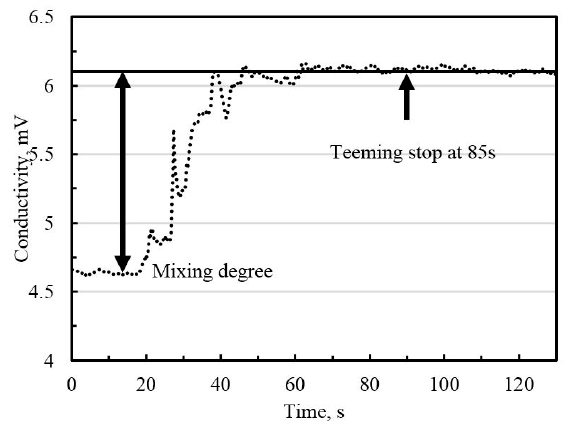
Figure 9. Typical tracer homogeneous curves in different probes.